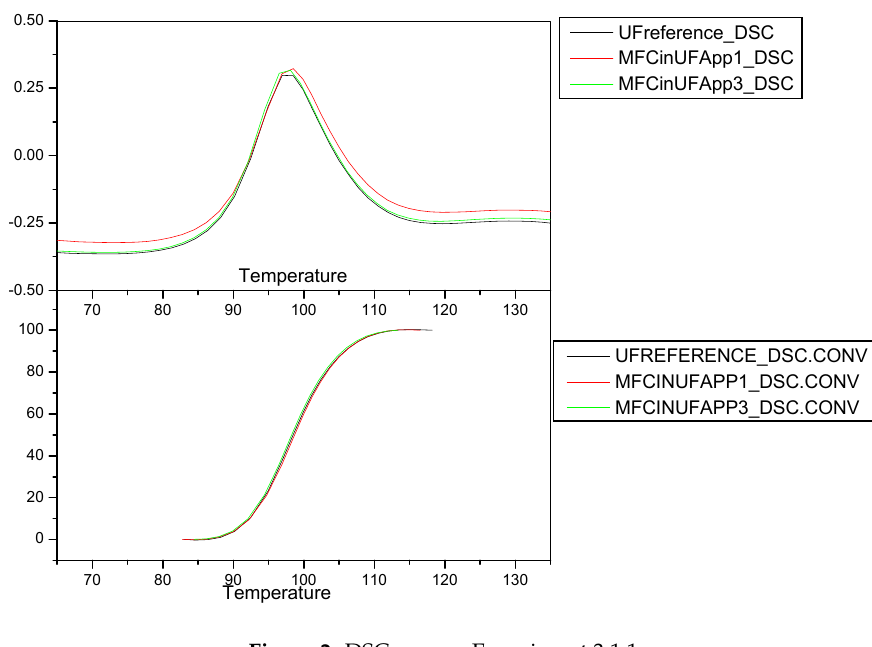
Figure 2. DSC curves, Experiment 3.1.1.